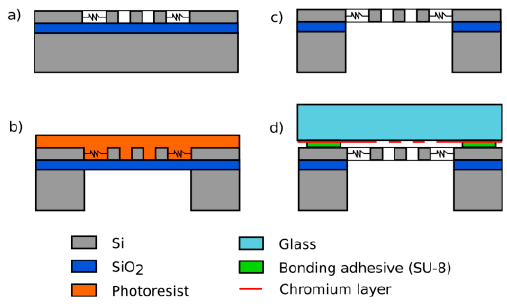
Figure 2. Fabrication process. ( a ) Structuring of the device layer. ( b ) Backside DRIE to remove the substrate beneath the structures. ( c ) HF etching of the sacrificial SiO 2 layer. ( d ) Bonding of the glass wafer with